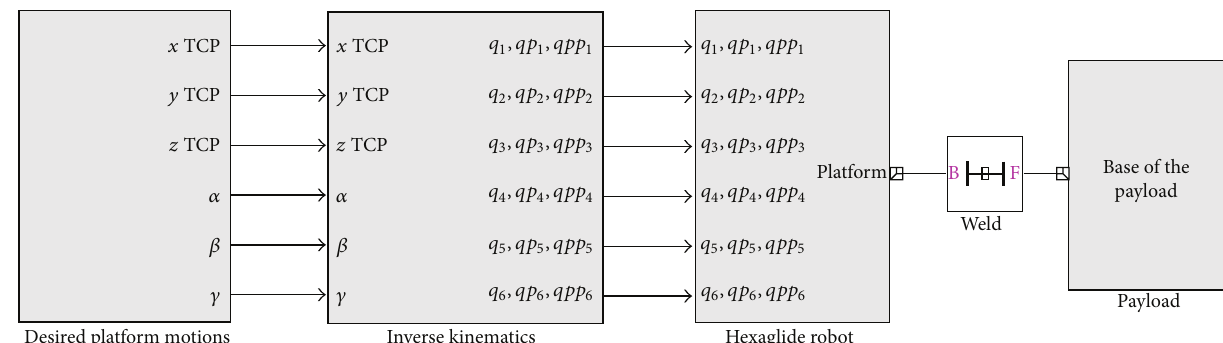
Figure 2: SimMechanics robot model for inverse dynamic solution.